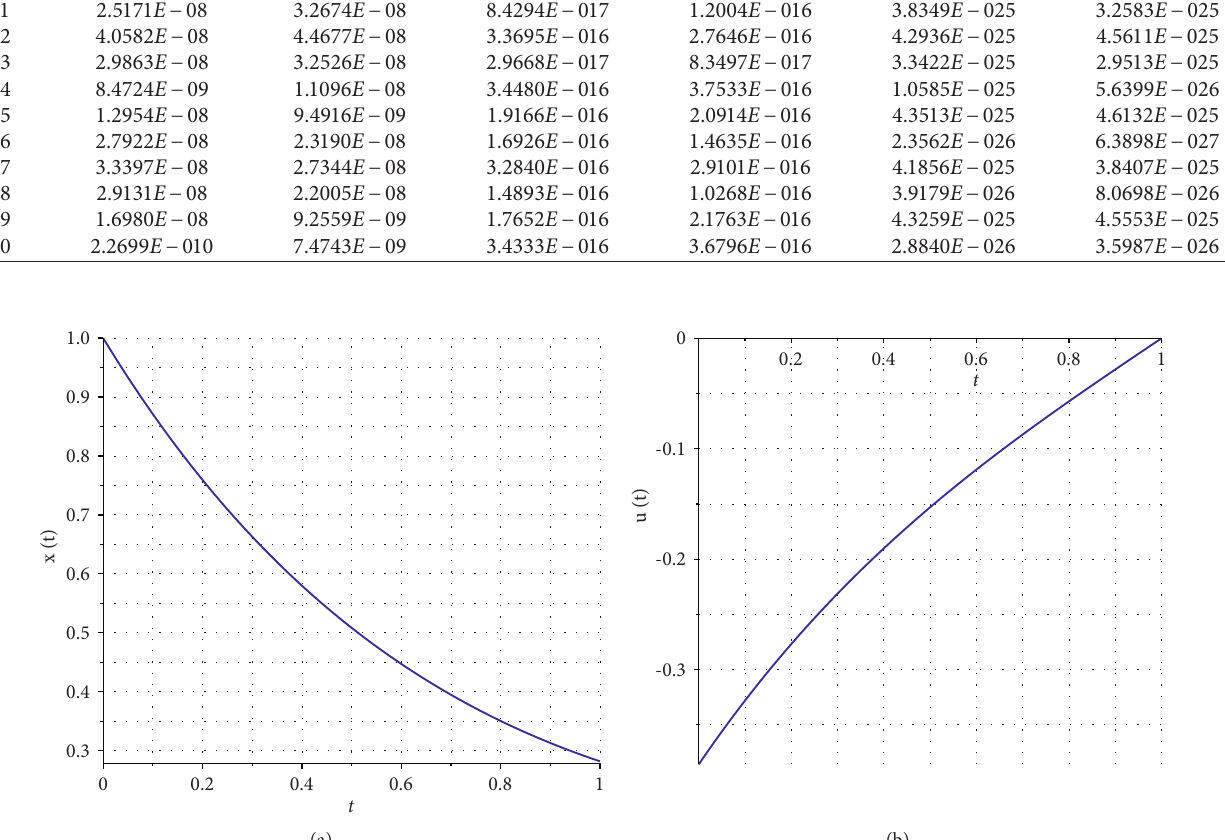
Figure 2: Approximate solutions of x ( . ) and u ( . ) with N � 10 for α � 1 in Example 2. (a) Approximate solution of x ( . ) . (b) Approximate solution of u ( . )